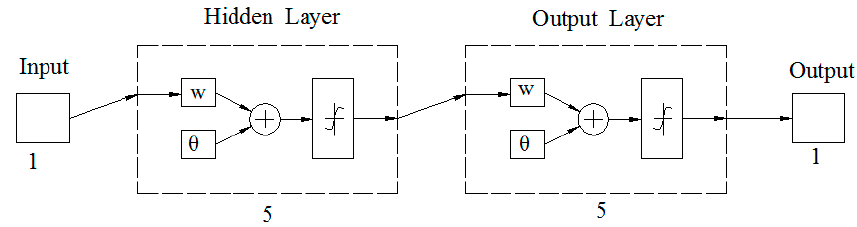
Figure 5. Structure of the back propagation (BP) artificial neural network.